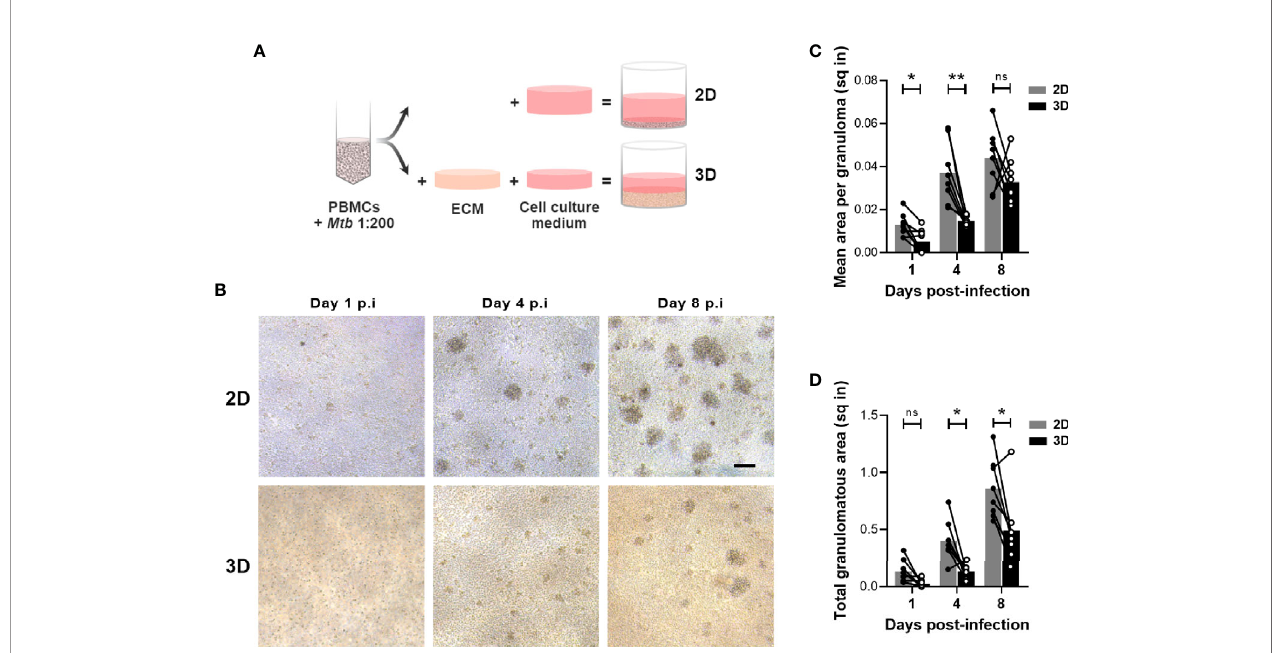
FIGURE 1 | Development of in vitro granulomas is delayed in the 3D model. (A) Schematic representation of the side-by-side experimental setup. ECM, extracellular matrix. (B) Bright fi eld images of in vitro granulomas formed in the absence (2D) or presence (3D) of an ECM from a representative donor, viewed under 10X magni fi cation. Scale bar = 100 m m. (C, D) Quanti fi cation of mean granuloma size (C) and total granulomatous area (D) . Circles represent the area in square inches (sq in) of all cell aggregates observed in a representative image for each individual donor, lines connect results from the same donor, and bars indicate mean values of eight donors. Statistical analysis was performed using two-way repeated measures ANOVA and Sidak ’ s multiple comparisons test. ns, non-signi fi cant; * p < 0.05; ** p <